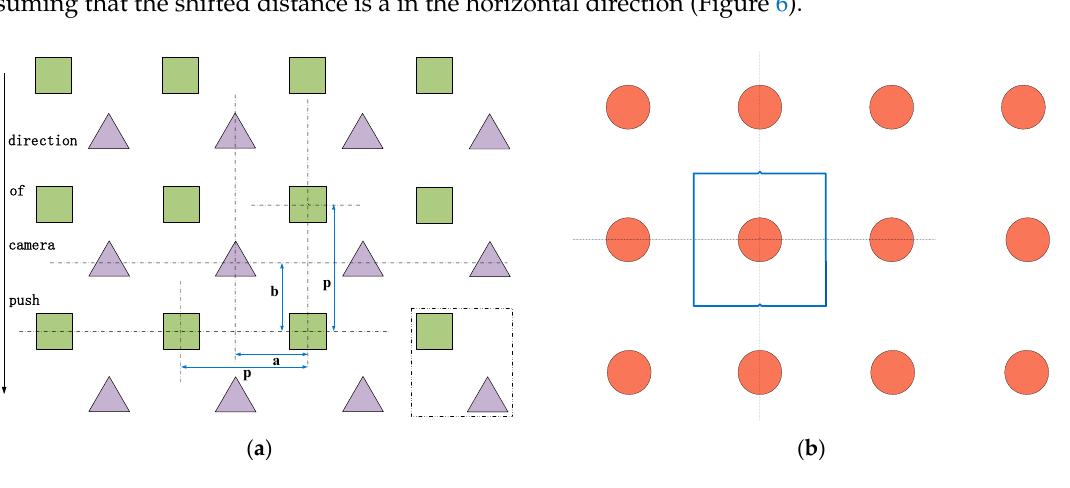
Figure 6. Sampling results of TDI–CCD. ( a ) Sampling results of TDI-CCD pairs; ( b ) Sampling results of TDI-CCD pairs after partition.